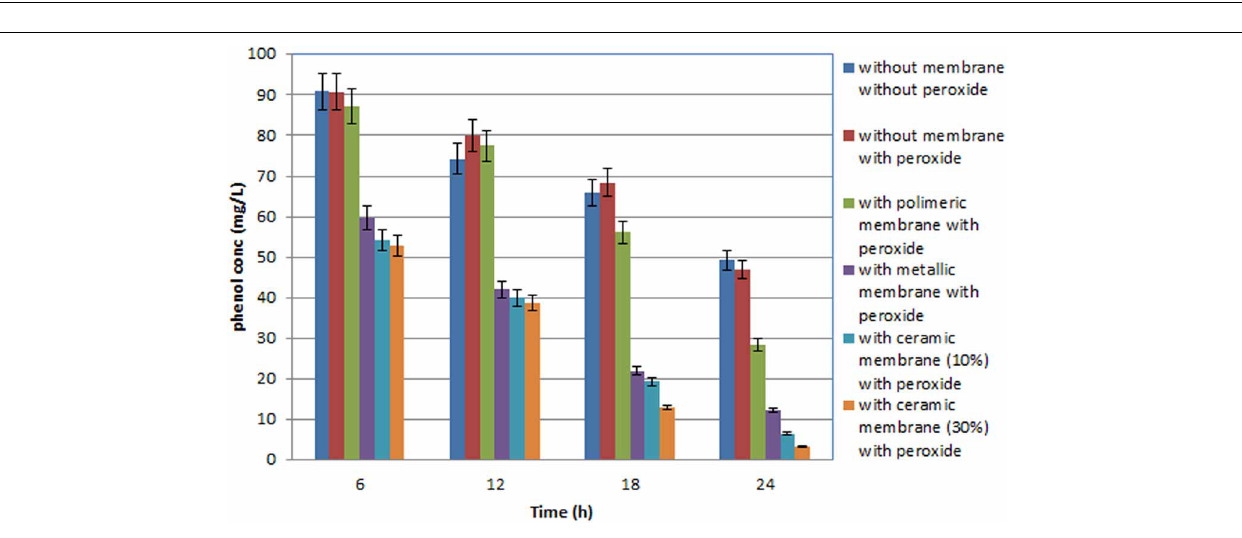
FIGURE 4 | Total phenolic compound variation in the OMW during batch experiment with the three different membranes used with olive mill wastewater (diluted 1:100 with distilled water), performed with a (450W) high pressure UV